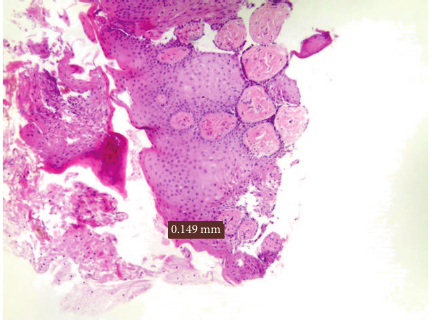
Figure 10: Damage measurement in a melanotic